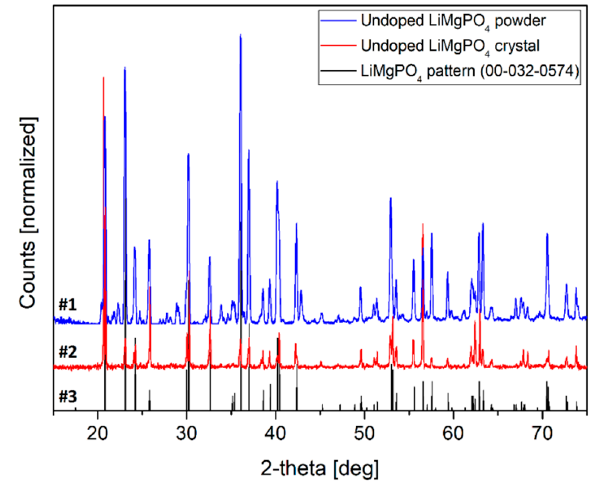
Figure 3. The XRD diffraction patterns of the undoped LiMgPO 4 samples in form of powder (#1), crystal (#2) and reference pattern (#3).